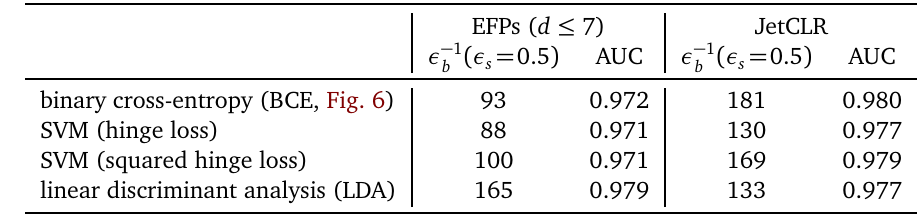
Table 3: Comparison of JetCLR representations and energy flow polynomials (EFPs) as in Fig. 6, including different linear classifier